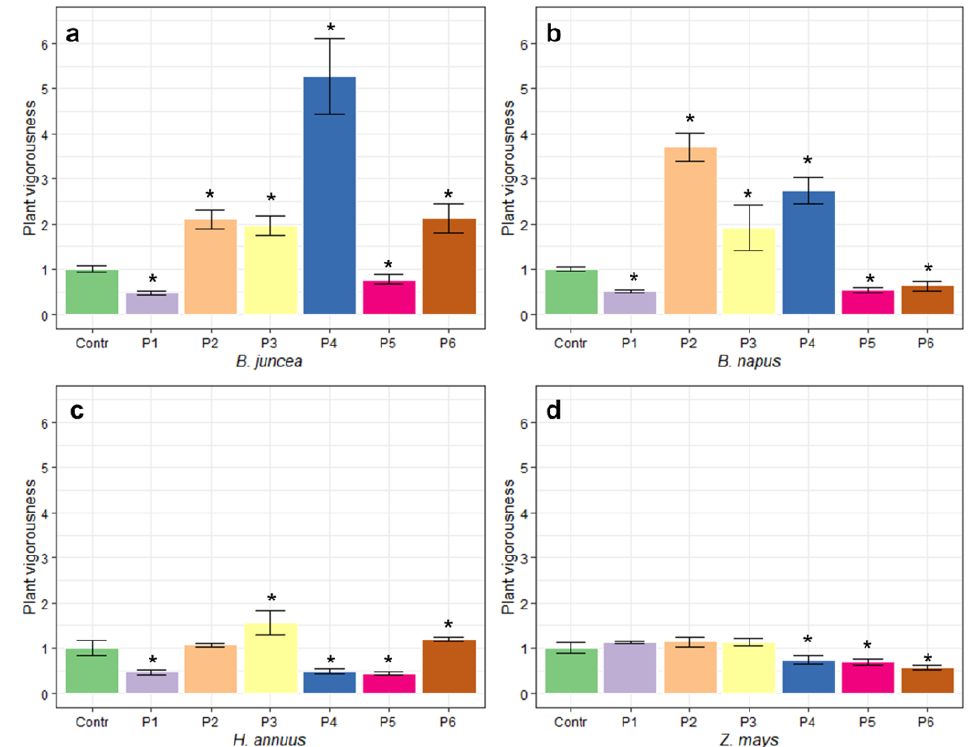
Figure 1. Index of plant vigorousness of ( a ) B. juncea , ( b ) B. napus , ( c ) H. annus and ( d ) Z. mays grown on SS from different WWTPs. Stars above each column indicate samples significantly different from the control (T/Wilcoxon tests, p < 0.05). Complete dataset in Supplementary Table S2.